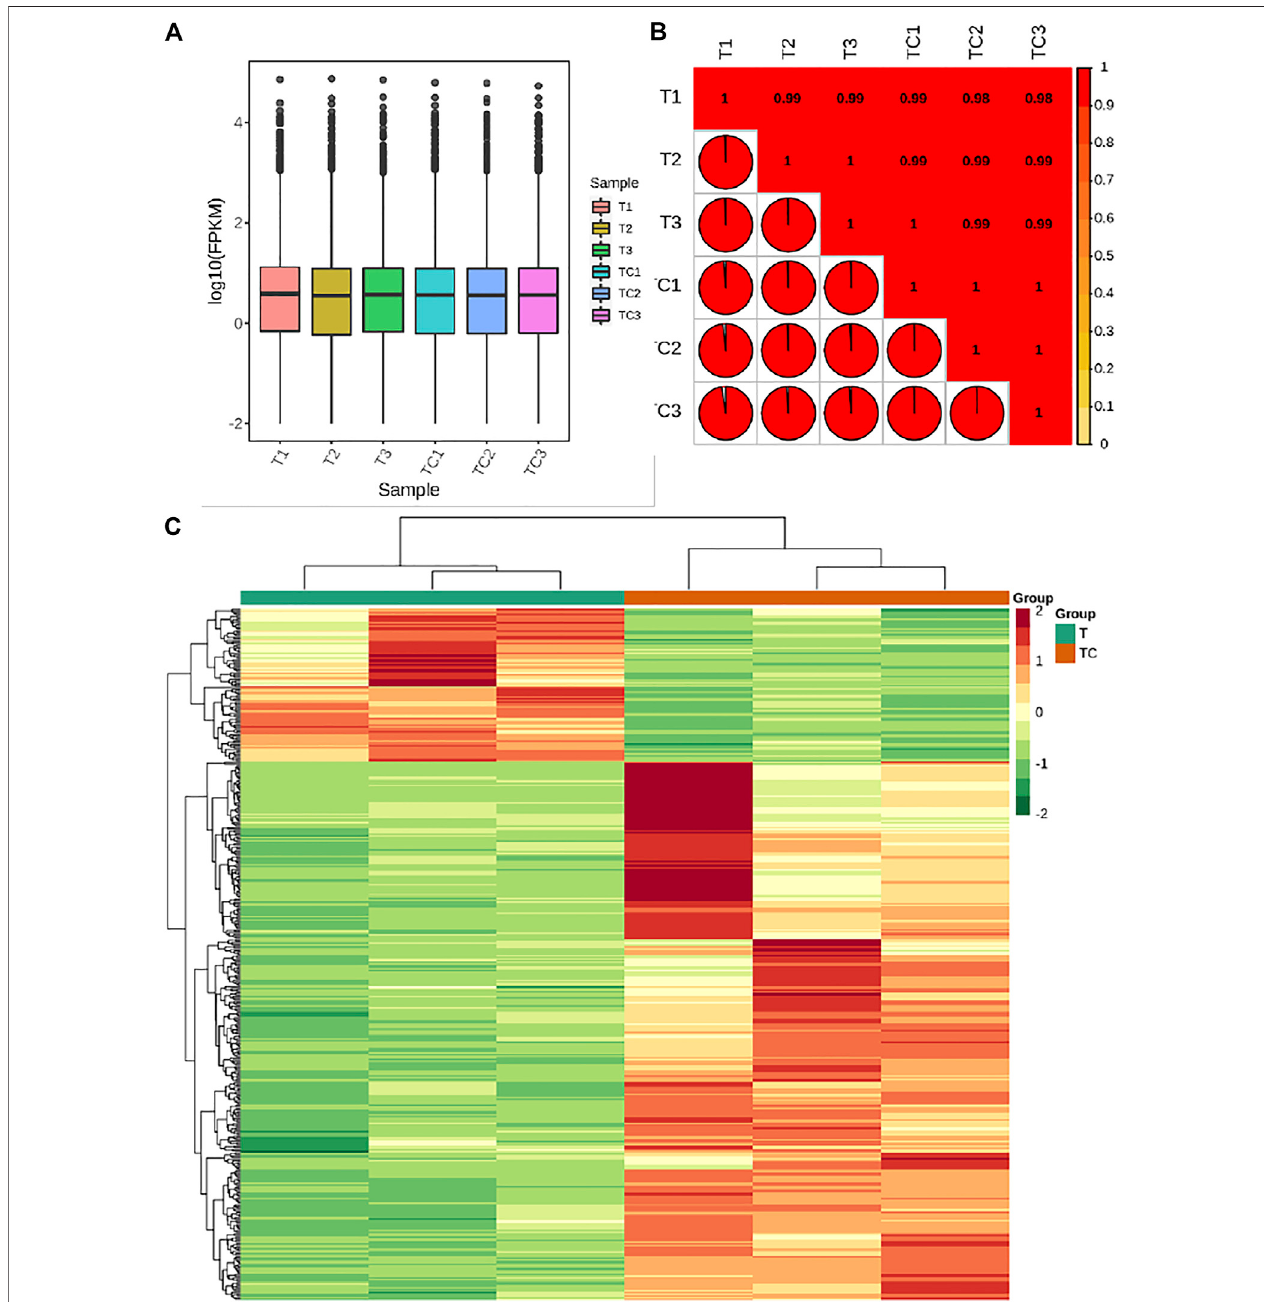
FIGURE 3 | (A) Overall Fragments Per kilobase of Transcript per Million fragments mapped for UV-C treated M. nana (T) and control (CK). (B) Pearson Correlation Coef fi cient between the UV-C and CK replicates. (C) Heatmap and hierarchical clustering of the expression of differentially expressed genes (DEGs) between UV-C and CK bananas. Differential gene expression between UV-C and